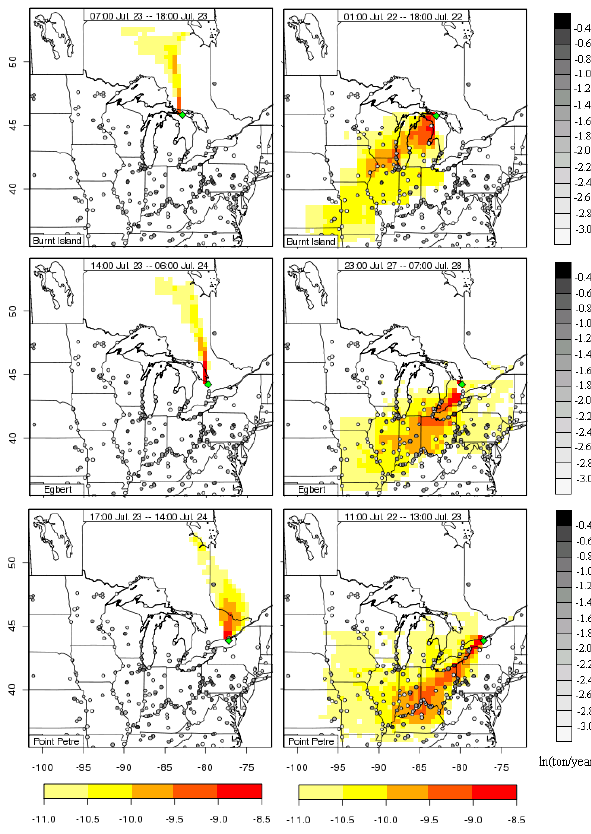
Fig. 8. Similar to Fig. 7: Source contributions [log 10 (ppm)] for the selected Hg plumes (right) and low episodes (left) in 26 May–4 June for Burnt Island (top), Egbert (middle) and Point Petre (bottom).